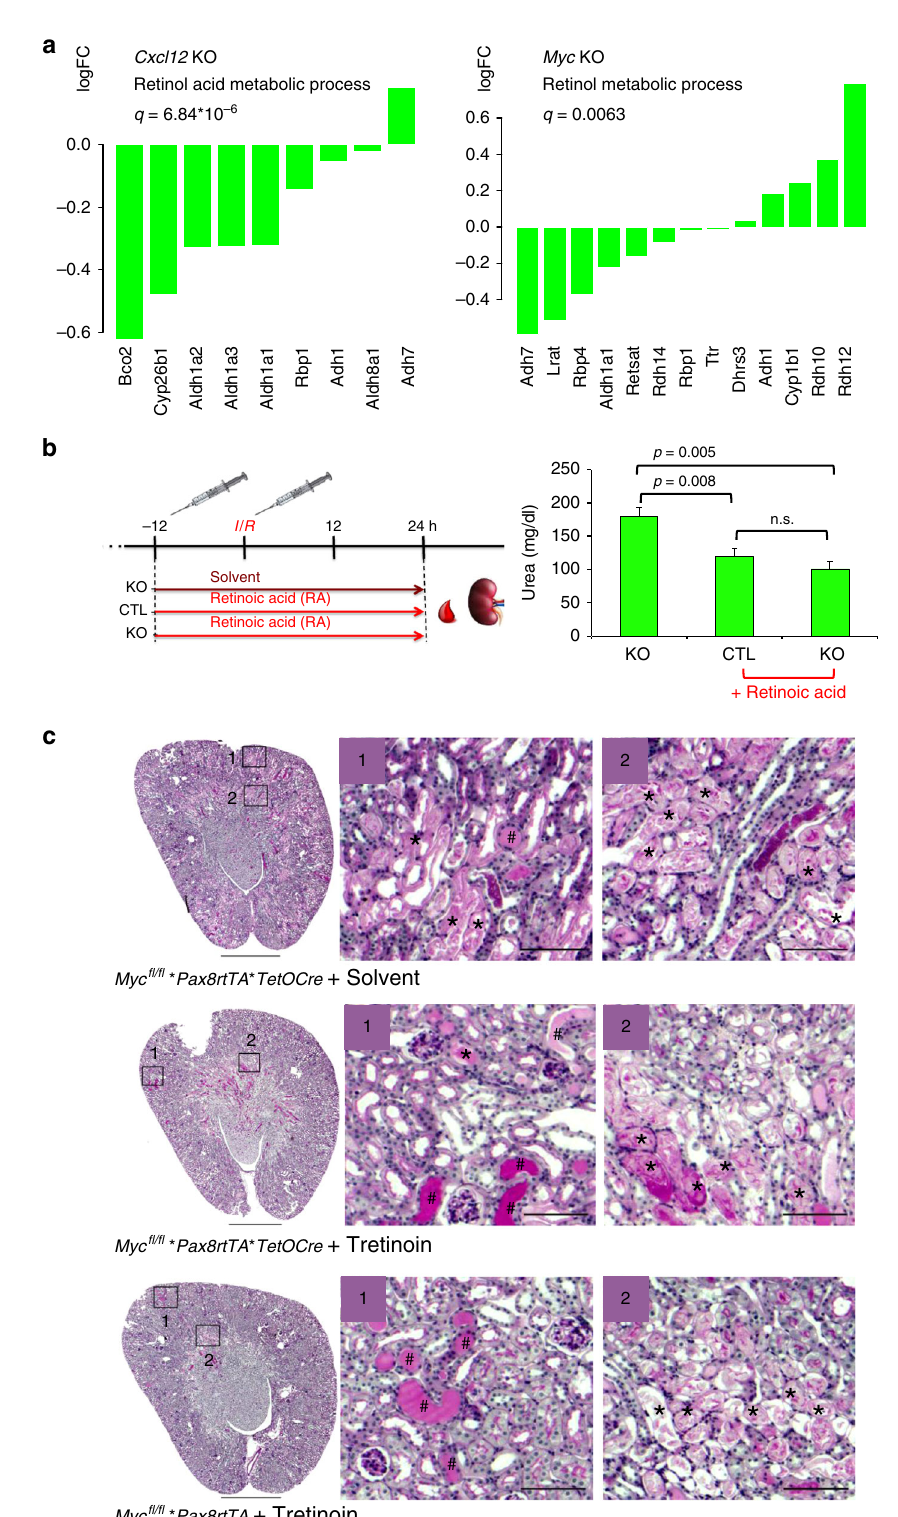
Fig. 7 Retinoic acid accelerates the recovery after injury. a GO term analysis of Cxcl12 fl / fl - and Myc fl / fl * Pax8rtTA*TetOCre compared to control mice revealed suppressed retinol acid metabolic and retinol metabolic processes, respectively; the individual genes of the GO term are depicted. b Myc fl / fl *PAX8rTA/TetOCre (KO) ( n = 13) and Myc fl / fl *PAX8rTA (control animals) ( n = 7), lacking the Cre recombinase were treated with doxycycline for 2 weeks, followed by a washout period of 1 week. Tretinoin (RA, 40mg/kg) was applied 12h before and during the ischemia/reperfusion injury to seven control and six KO mice. Eight KO mice were injected with an equal volume of cottonseed oil, only (solvent). One of the untreated animals was removed from further analysis due to bleeding and incomplete clamping. Urea levels were measured 24h after surgery. Differences between mice treated with RA and untreated animals were statistically signi fi cant (means±SEM; * p <0.05; t -test), while there were no differences between RA-treated control and Myc KO mice. c Histology of the cortical and medullary region revealed signi fi cant tubular injury with intraluminal debris (*) and casts (#) in all three groups after ischemia/reperfusion injury (scale bars, 1mm and 100 µ